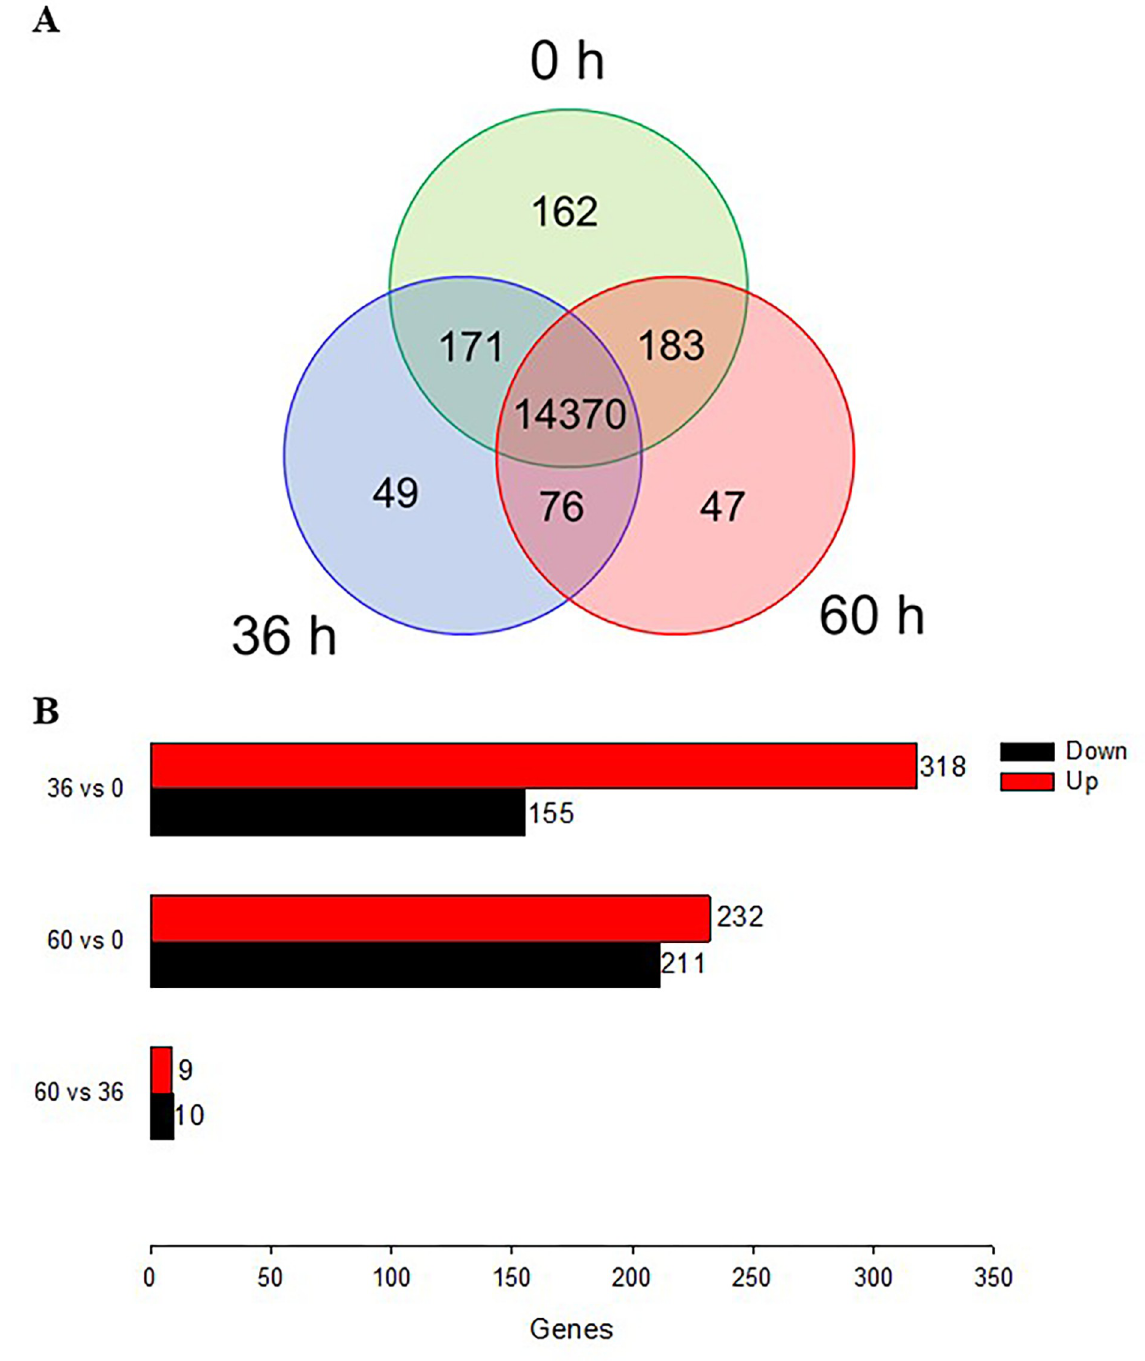
Fig 2. DEG analysis of different ages of F . occidentalis females. The assessment used genes mapped with RNASeq reads (see Table 1). (A) Venn diagram of total transcripts at 0 h, 36 h, and 60 h after emergence. (B) DEG analysis between two different developmental stages. The threshold was > 2-fold changes in